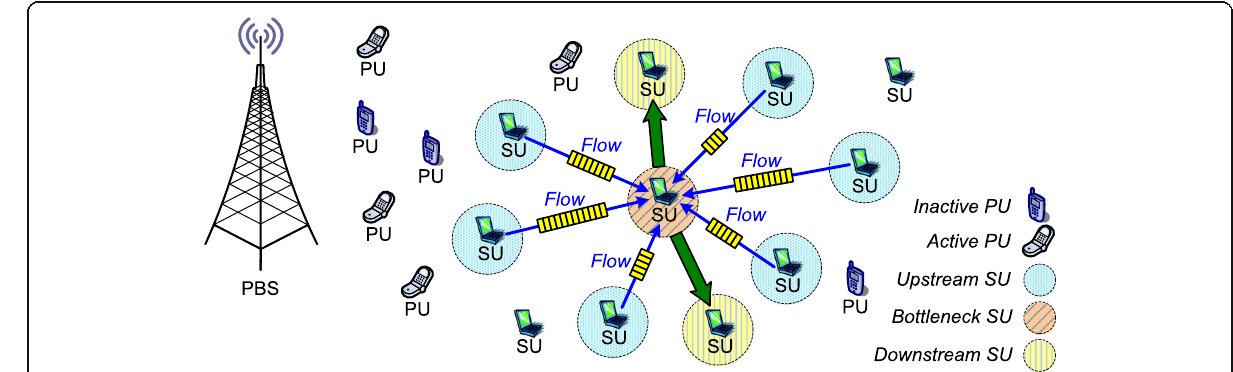
Fig. 1 Network model of the underlay multi-hop CRANET where SUs share uplink channels with